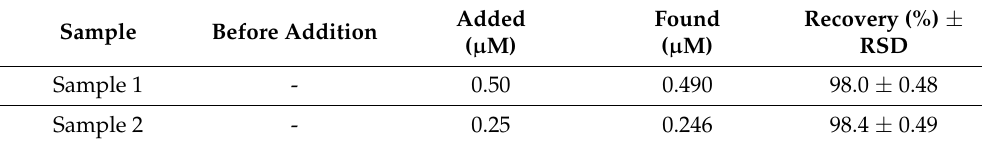
Table 3. The recovery percentage of the VEN solution using Co–Pd@Al 2 O 3 /GCE in serum